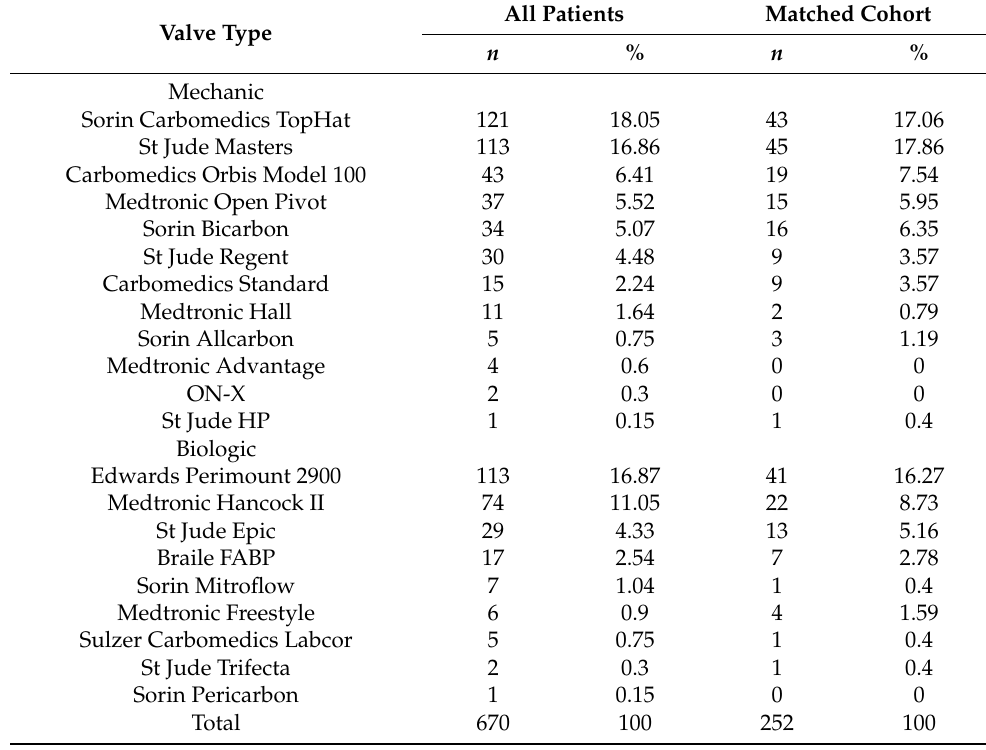
Table 2. Prostheses used in our